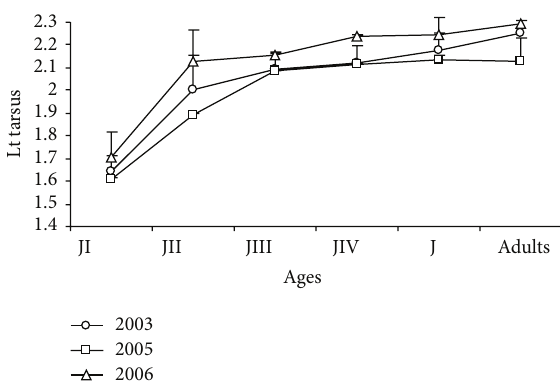
Figure 12: Mean of the tarsus (cm) of Sterna hirundinacea